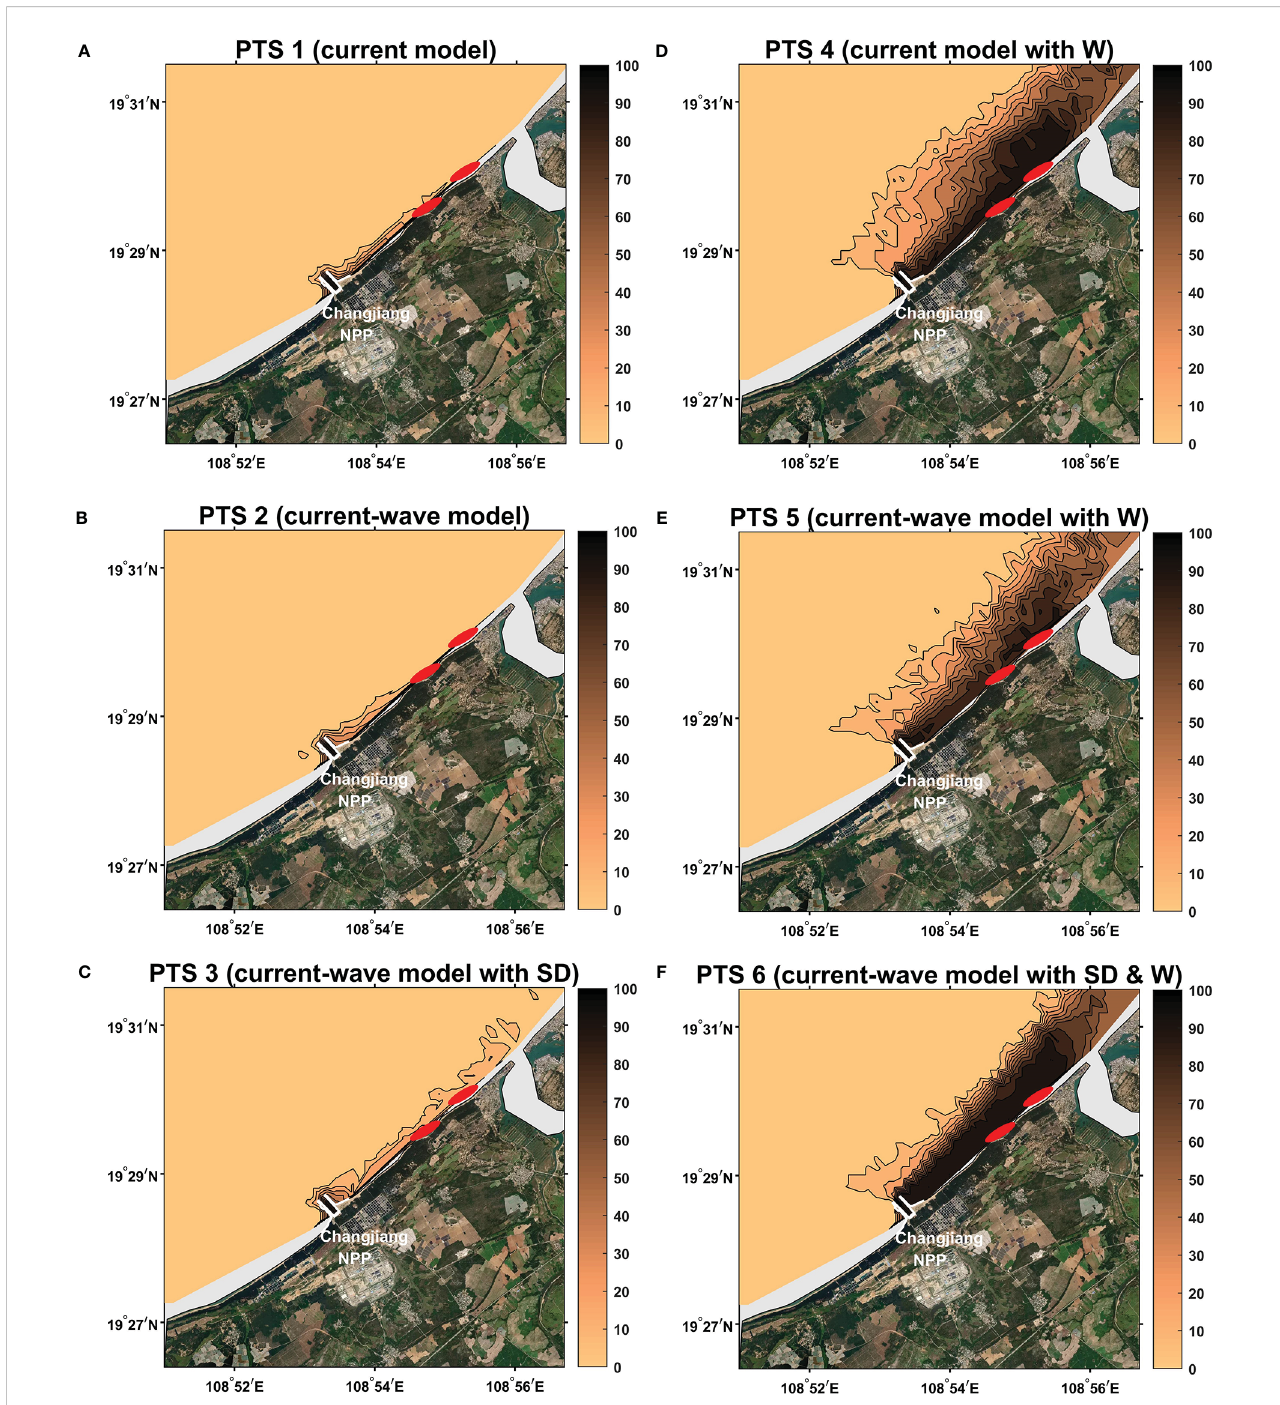
FIGURE 5 (A – F) Probabilistic intensity distributions of different particle-tracking simulation results. Color shading represents the odds (expressed as a percentage) of the particles released in the region being transported into the NPP ’ s inlet. The higher the value, the greater the likelihood that particles released at that location are transported into the inlet during the simulation period. The two red elliptical markers indicate the locations of two gulfweed sources near the